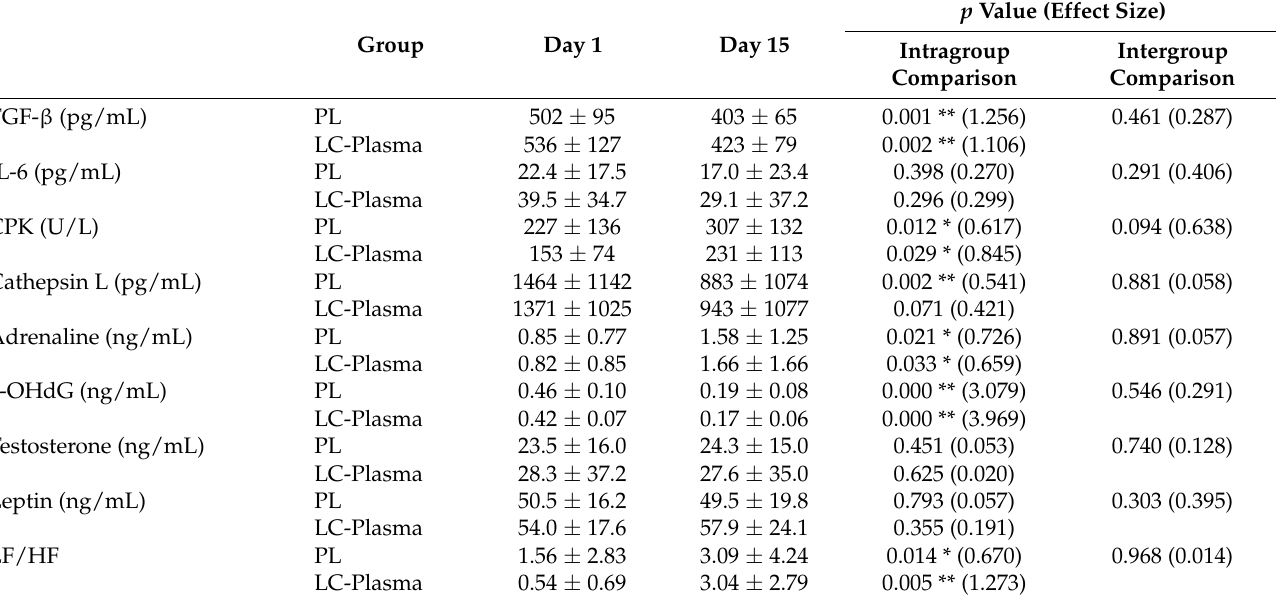
Table 5. Changes in hematological and physiological indices during the continuous exercise